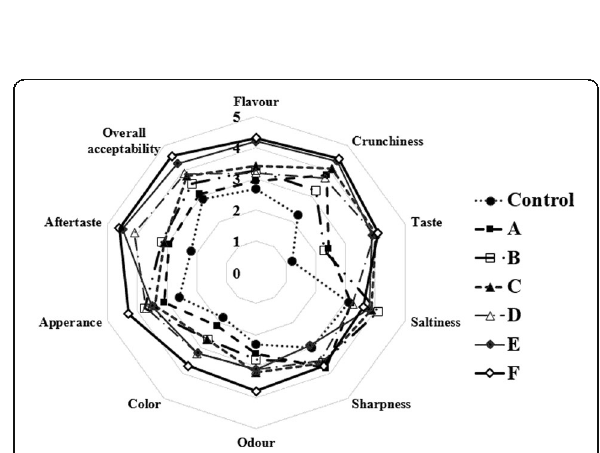
Fig. 6 Sensory analysis of lacto-fermented cucumber after fermentation period. Control: without bacterial inocula with 4% (w/ v) NaCl, pH 4; A: L. plantarum NPL 1258 with 4% (w/v) NaCl, pH 4; B: L. plantarum NPL 1258 with 4% (w/v) NaCl, 0.2% inulin, pH 4; C: P. pentosaceus NPL 1264 with 4% (w/v) NaCl, pH 4; D: P. pentosaceus NPL 1264 with 4% (w/v) NaCl, 0.2% inulin, pH 4; E: L. plantarum NPL 1258 and P. pentosaceus NPL 1264 with 4% (w/v) NaCl, pH 4; F: L. plantarum NPL 1258 and P. pentosaceus NPL 1264 with 4% (w/v) NaCl, 0.2% inulin, pH 4. Results are means of three independent experiments with three repetitions ± SD, n =